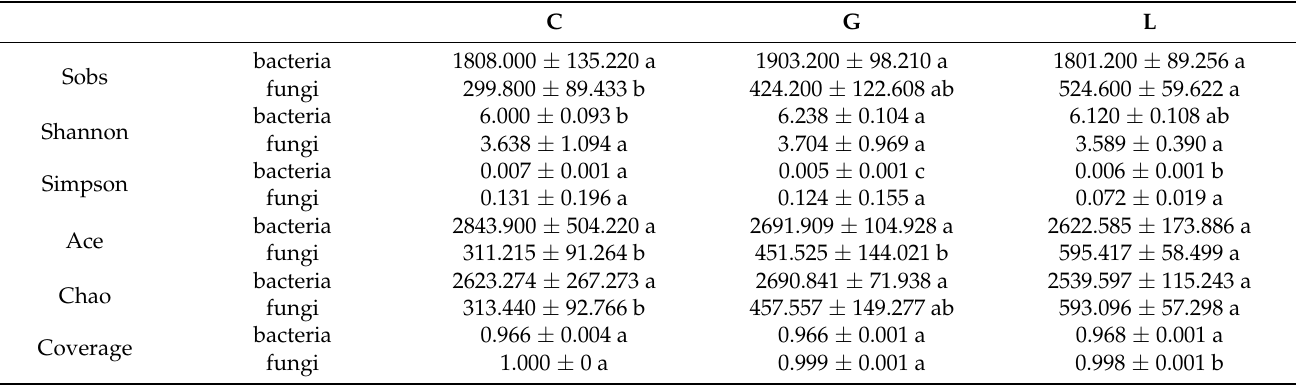
Table 4. Variation characteristics of α diversity of bacterial and fungal communities in three planted cover soils. Different lowercase letters indicate significant differences according to Duncan’s test ( p < 0.05).